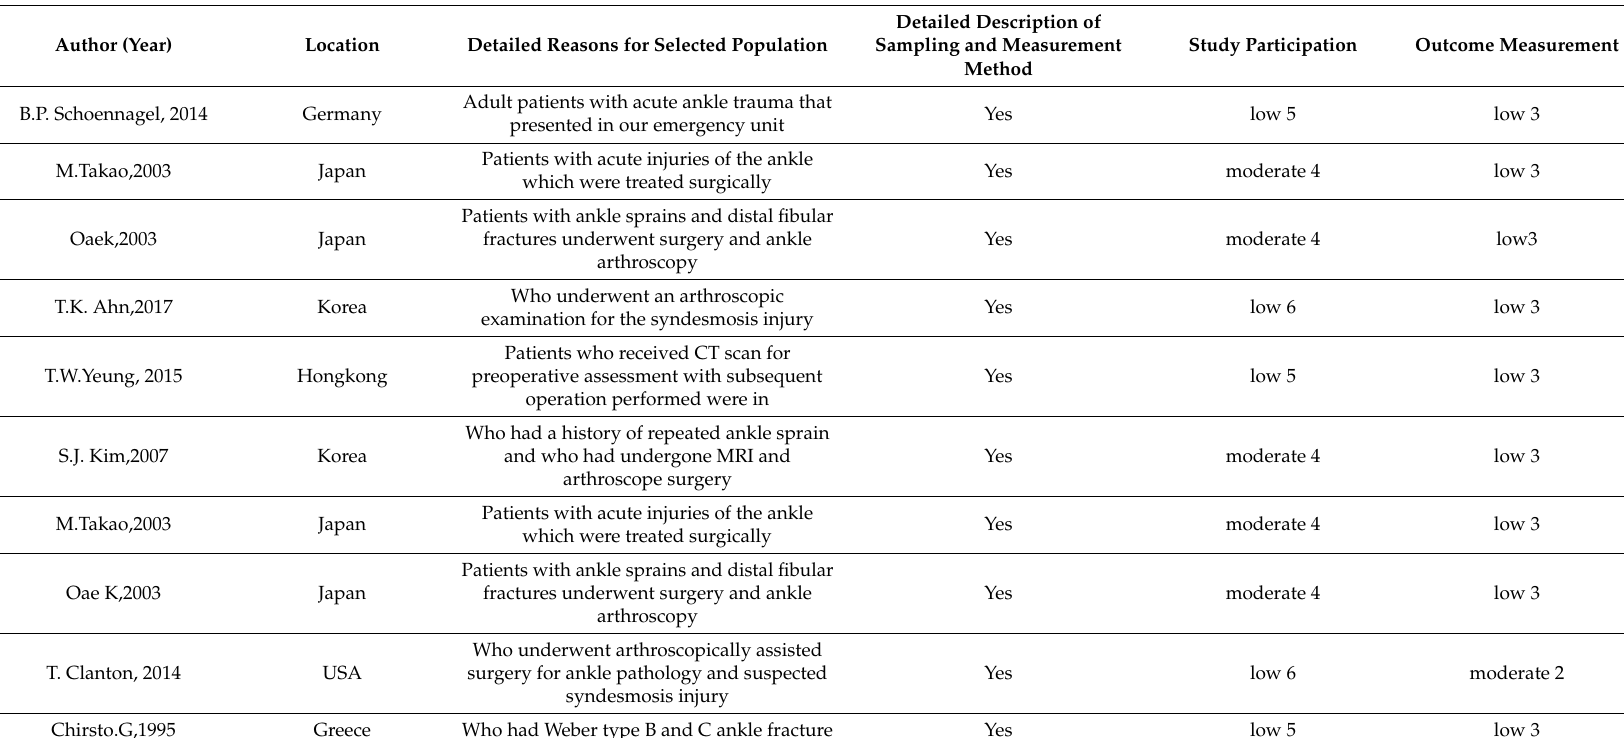
Table 2. Risk of bias for included